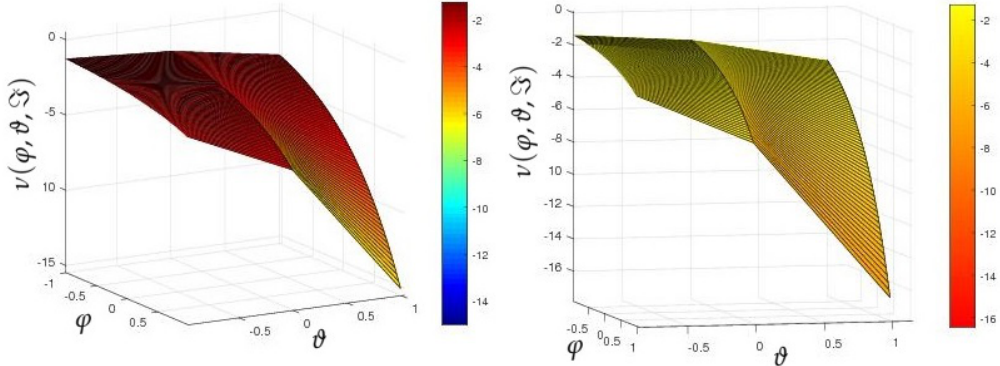
Figure 6. The HPTM graphs of δ = 0.6 and 0.4 of ν ( ϕ , ϑ ) , Example 1.